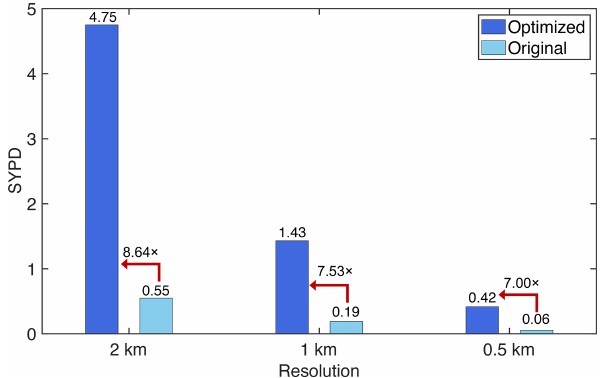
Figure 15. The computing throughput results using 27988480 cores. The SYPD (simulated years per day) increases from 0.19 to 1.43 with the 1km resolution. The optimized performance is 7.53 times better than that of the original